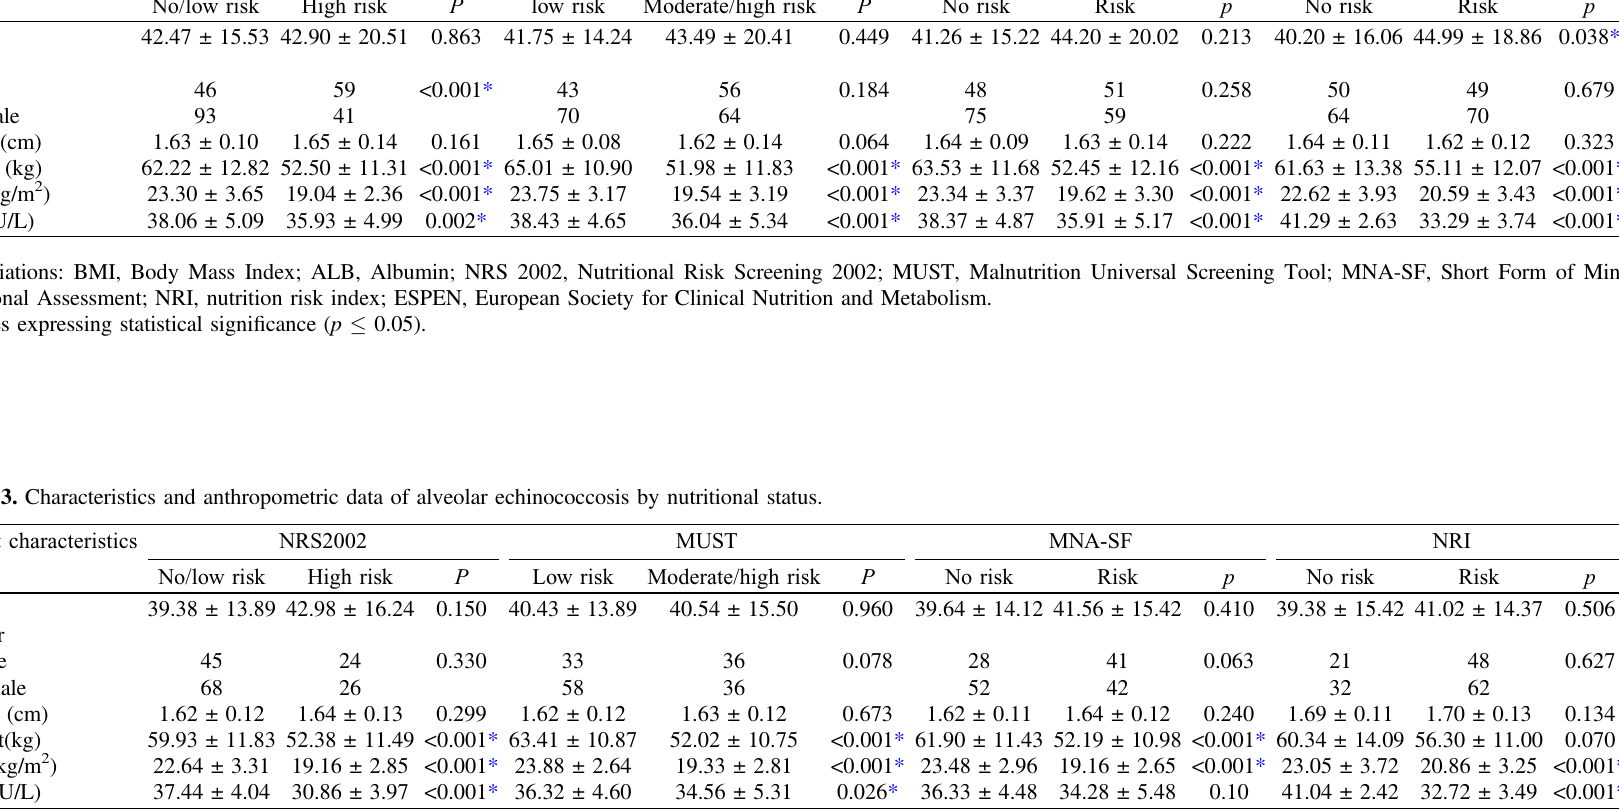
Table 2. Characteristics and anthropometric data of cystic echinococcosis by nutritional status. Patient characteristics